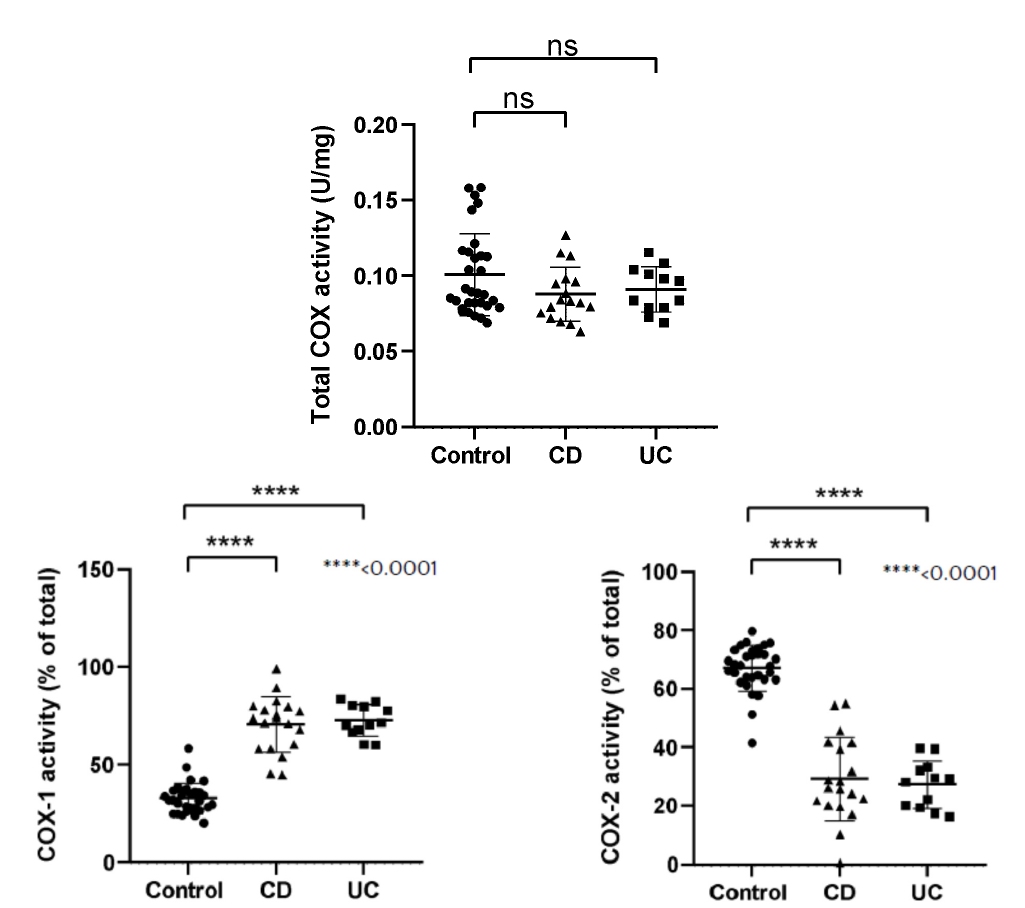
10 of 22 Figure 2. Total antioxidant concentration (TAC) (mM/mg sample), activity of superoxide dismutase (SOD, U/mg sam- ple),activity of catalase (CAT, U/mg sample), concentration of total glutathione (GSH, uM/mg sample), concentration of oxidized glutathione (GSSG, uM/mg sample) and activity of glutathione peroxidase (GPX, U/mg sample) per milligram tissue sample in healthy subjects (Control), in patients with Crohn’s disease (CD) and ulcerative colitis (UC).